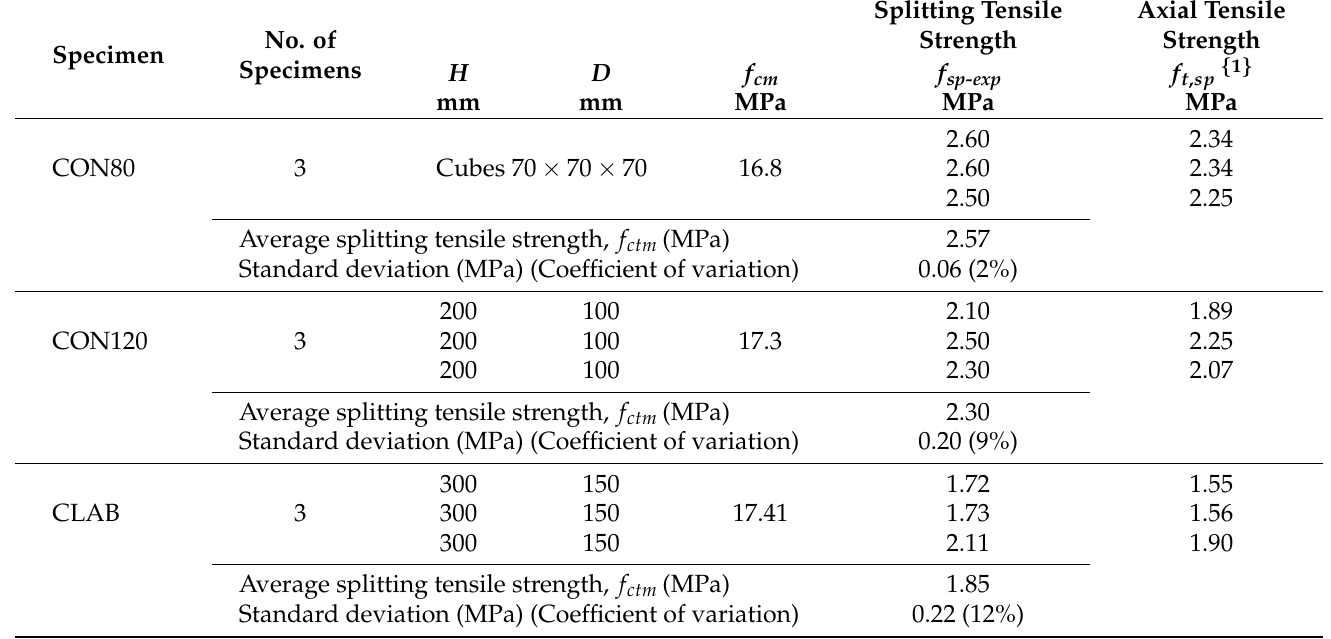
Table 8. Splitting tensile strength of the low-strength standard